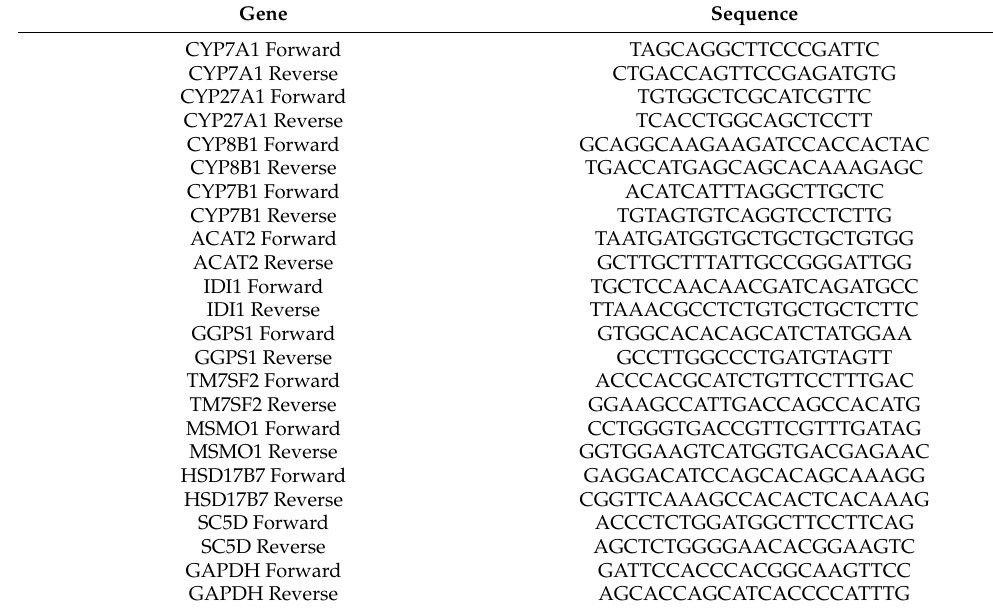
Table 1. The table of gene primer